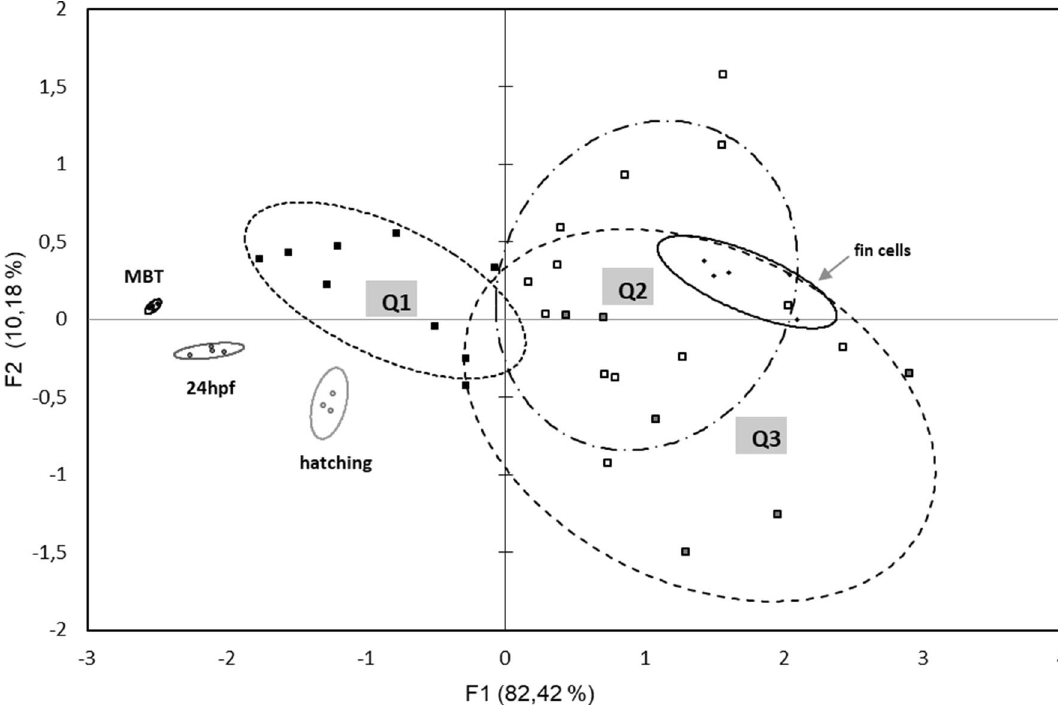
Figure 7. Biplot of principal-components analysis (PCA) showing the distribution of the clones and controls regarding their DNA methylation levels. Each dot represents one sample whose position is statistically determined from its closeness or farness to the other samples. The sample identity that was used for correlation calculations is based on their DNA methylation levels in pou2 , notail and nanog promoter regions. Samples include clones of different morphological qualities (Q1 > Q2 > Q3, see Fig. 5), and controls which include fertilized embryos at MBT (Mid Blastula Transition)-, 24 h-, and hatching-stage, and donor fin cells batches. The ellipses correspond to a 60% confidence in finding a sample type (Q1, Q2, Q3 clones or controls) within this area. The smaller the area, the lower data dispersion. Note on F1 axis (horizontal) that the ellipse of Q1 clones distributes the closest from the 24 h-control embryos, and the farthest from the fin cells